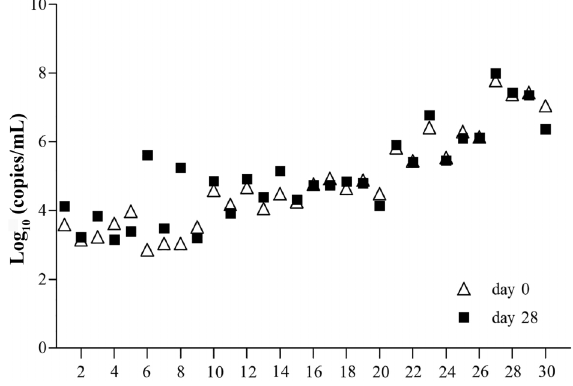
Figure 1. Comparison of Chlamydia trachomatis DNA concentra- tions using extracted DNA at day 0 and at day 28 of storage at 4°C.